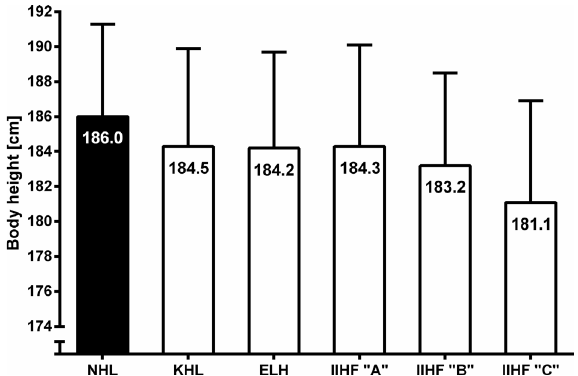
Figure 1. Values of body height of current players of ice hockey Canadian-American NHL, players of the Russian KHL, players of the Czech ELH and players in the world ranking by performance level IIHF.